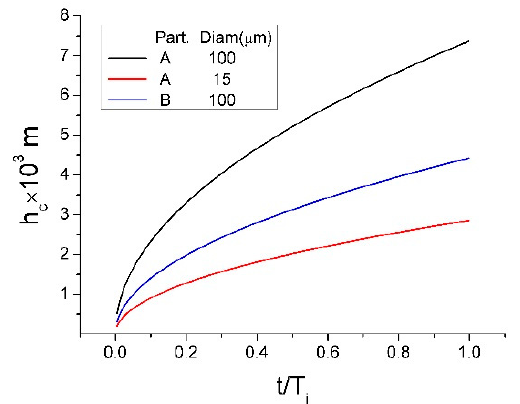
Figure 10. Time variation of the height increase of the liquid in the particle bed.